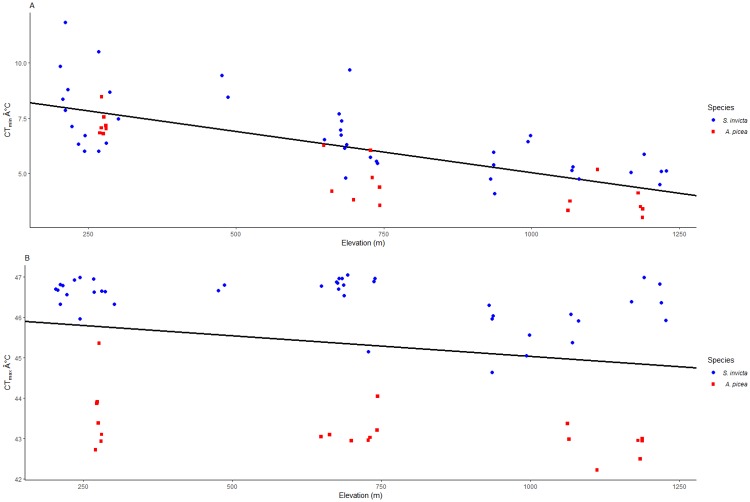
Regression plots showing Solenopsis invicta and Aphaenogaster picea CTmin with elevation (A), and CTmax with elevation (B).